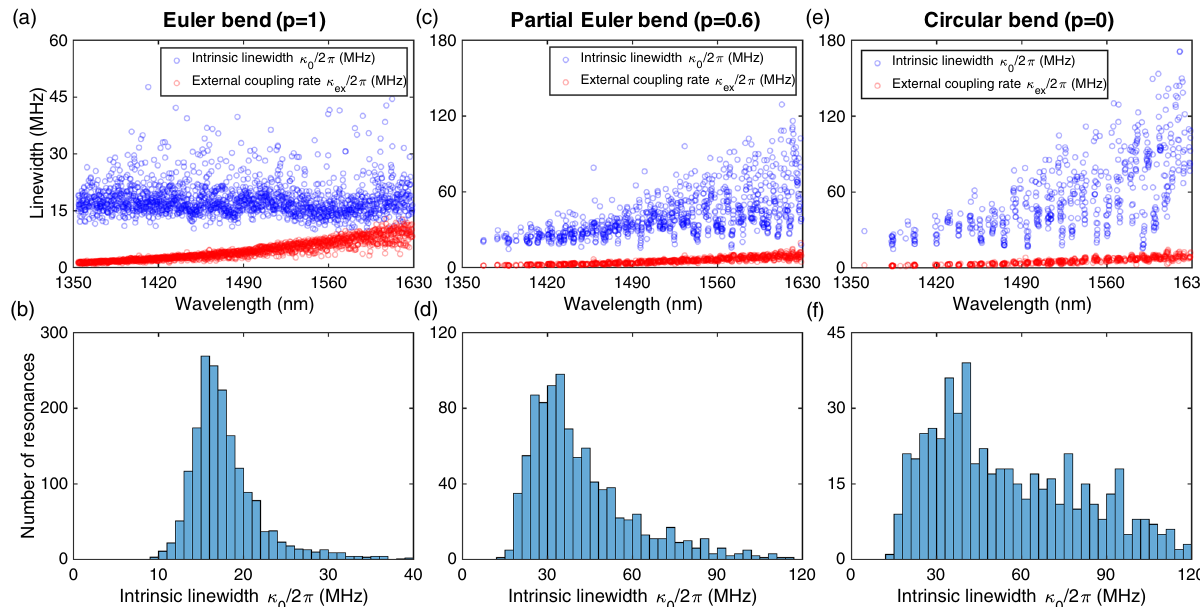
Fig. 2 Resonance linewidth characterization of racetrack microresonators with different bends. Racetrack microresonators with Euler bends (Euler portion p = 1) ( a , b ), partial Euler bends ( p = 0.6) ( c , d ), and circular bends ( p = 0) ( e , f ) are experimentally characterized. The data shown in ( a , c , e ) are measured intrinsic linewidth κ 0 /2 π and external coupling rate κ ex /2 π over a broad wavelength range for each sample. The data shown in ( b , d , f ) are histogram of κ 0 /2 π from ( a , c , e ) for each